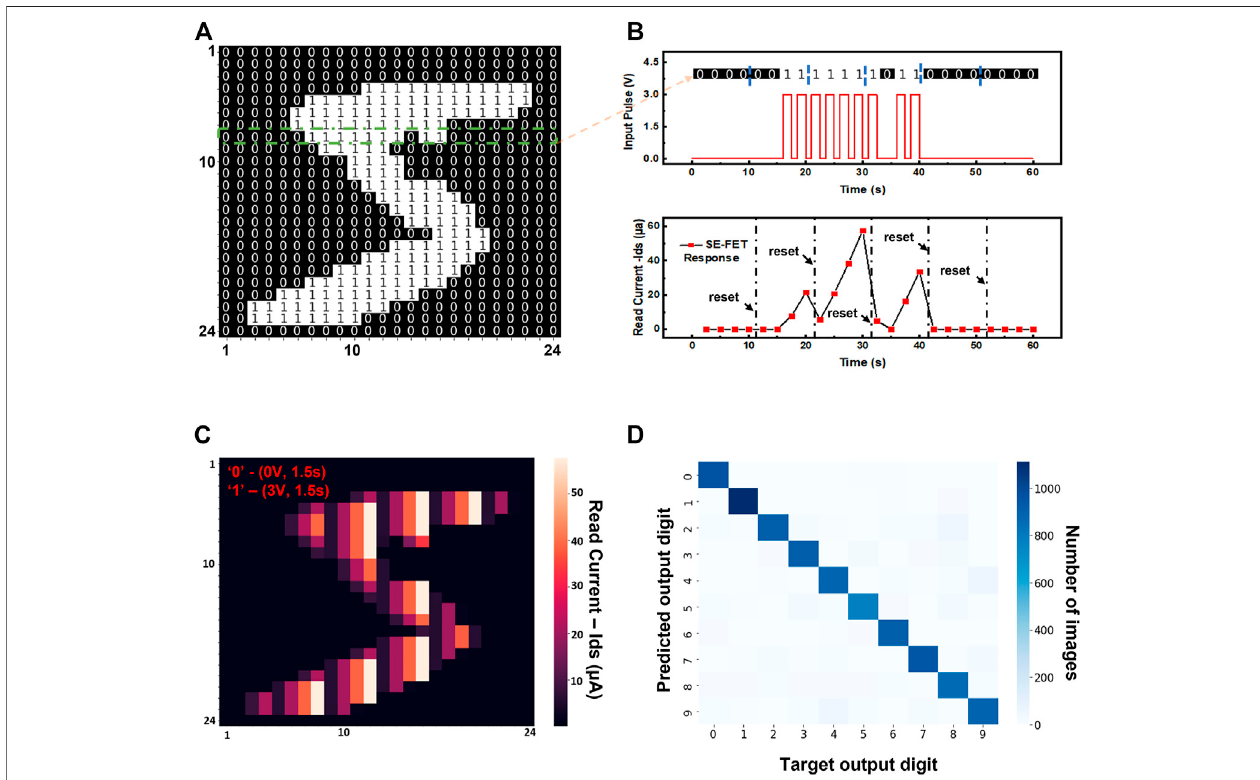
FIGURE 3 | Dynamic SE-FET-based RC system, for recognition of hand-written digits. (A) Pre-processed image of digit 5 as an example; the original grayscale imagewas fi rstconvertedintoabinaryimageandtheunusedborderareawasdeletedtoreducethesizeoftheoriginal28×28imageto24×24pixels. (B) Thetemporal responseofSE-FETtoaninputpulse streamforrownumber 7isshown asanexample.Theentirebinarysequenceoflength24wassub-divided into64-bitsequences which were converted into voltage pulse streams. Output response recorded upon application of the voltage pulse stream applied to the gate of the SE-FET after each input pulse as shown by the red dot. The device was reset to the initial state before the next sequence was fed. (C) The heatmap shows the complete recorded output response of digit 5. The magnitude of the read current ranging from (0- ~60 µa) adds to more levels of information than just 0 and 1, as in the case of the conventional approach. (D) Confusion matrix showing the experimentally obtained classi fi cation results of the SE-FET-based reservoir versus the correct outputs. An overall mean recognition of 91.19% is achieved.